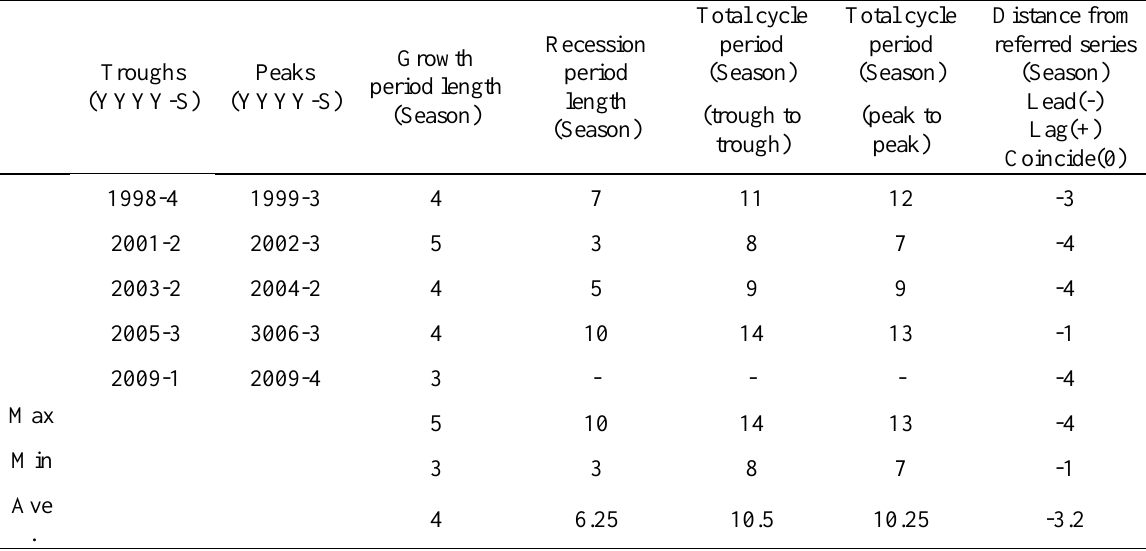
Table 9. Turning points of CLI and its comparison with reference series